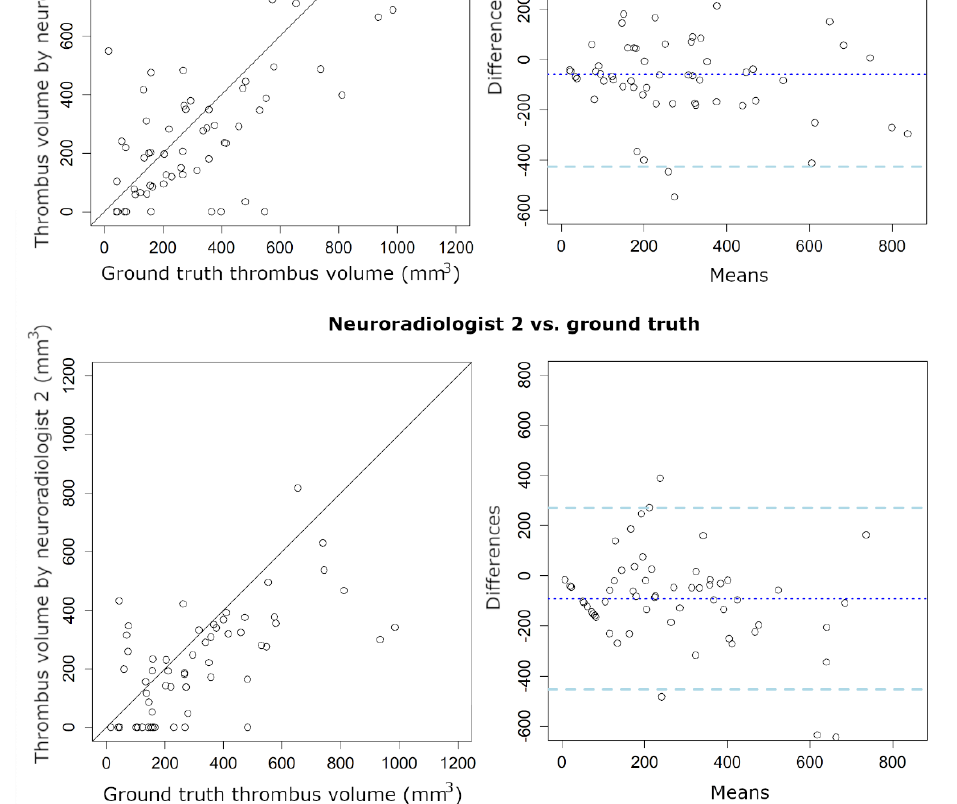
Figure 3. Scatter ( Left ) and Bland–Altman plots ( Right ) for thrombus volumes. The dotted line and dashed lines within the Bland–Altman plot represent the bias and limits of agreements,